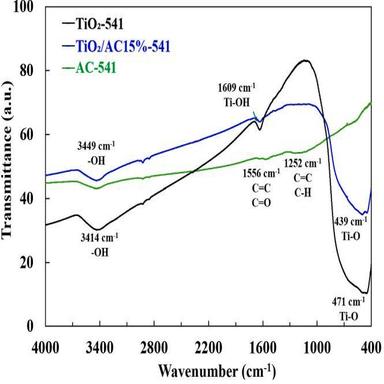
FTIR spectra for TiO2-541, TiO2-AC15%-541, and AC-541 materials.